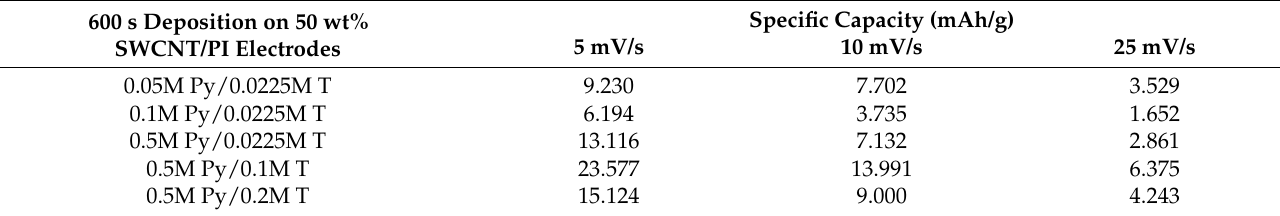
Figure 6. Transient current–time curves obtained during potentiostatic electrochemical polymeriza- tion of pyrrole onto the composite PI/SWCNT electrode. Table 1. Calculated specific capacities using cyclic voltammetry.